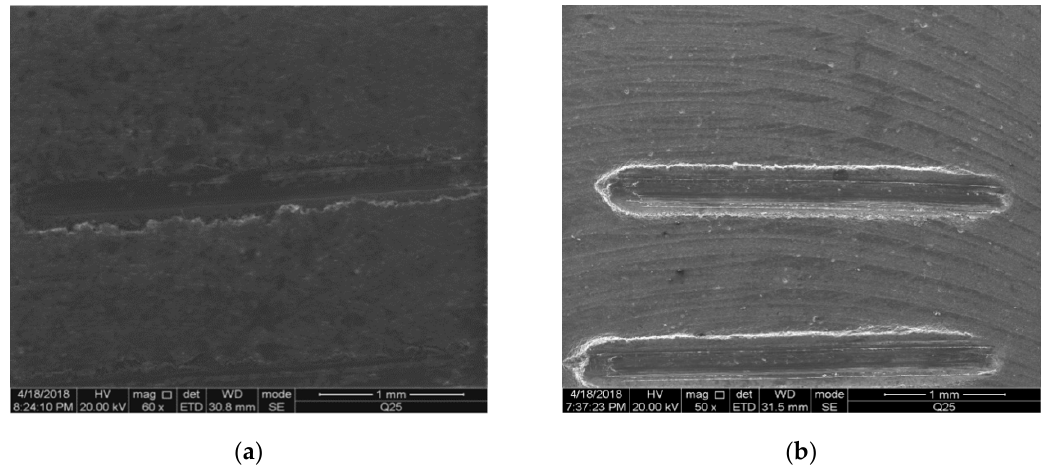
Figure 9. The surface of samples for measuring the adhesion: ( a ) the surface of the anodic oxide film / 60 N; ( b ) the surface of the DLC film / 90 N.